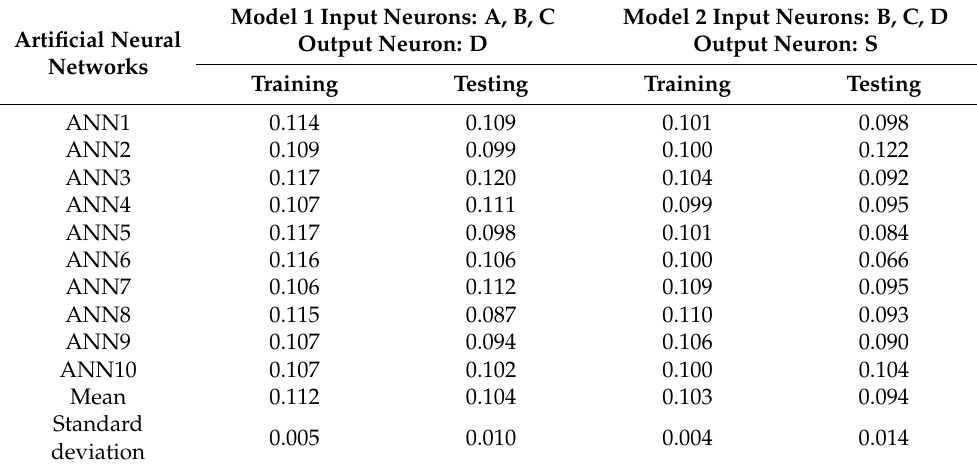
Table 11. RMSE values of